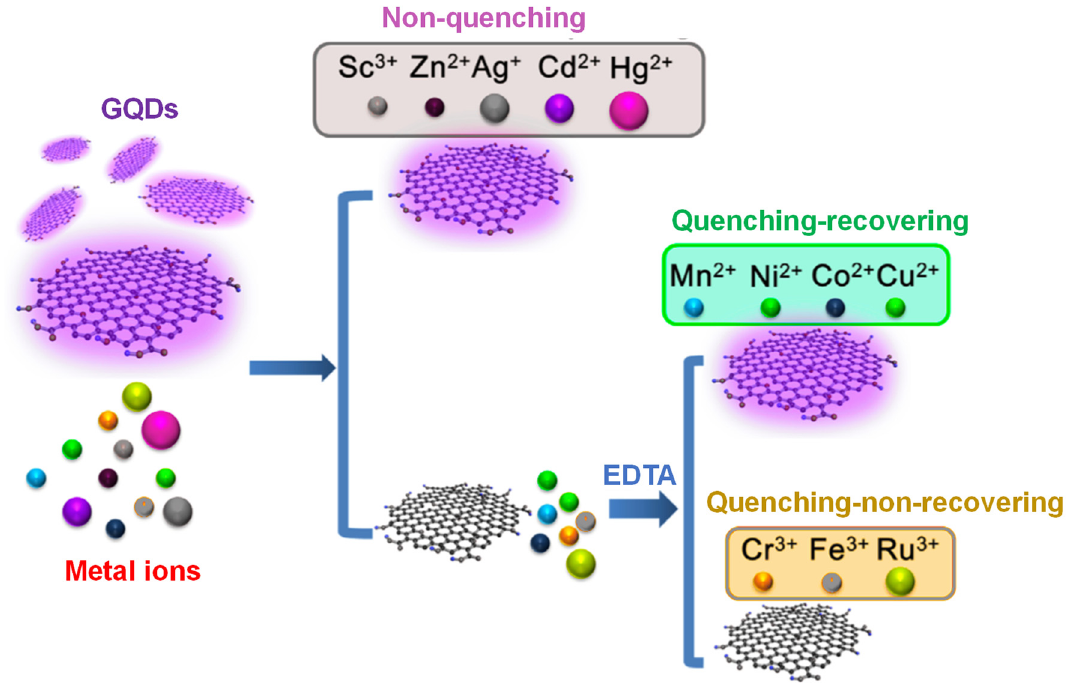
Figure 7. Schematic illustration of various transition metal ions and their influences on the PL of GQDs [168].